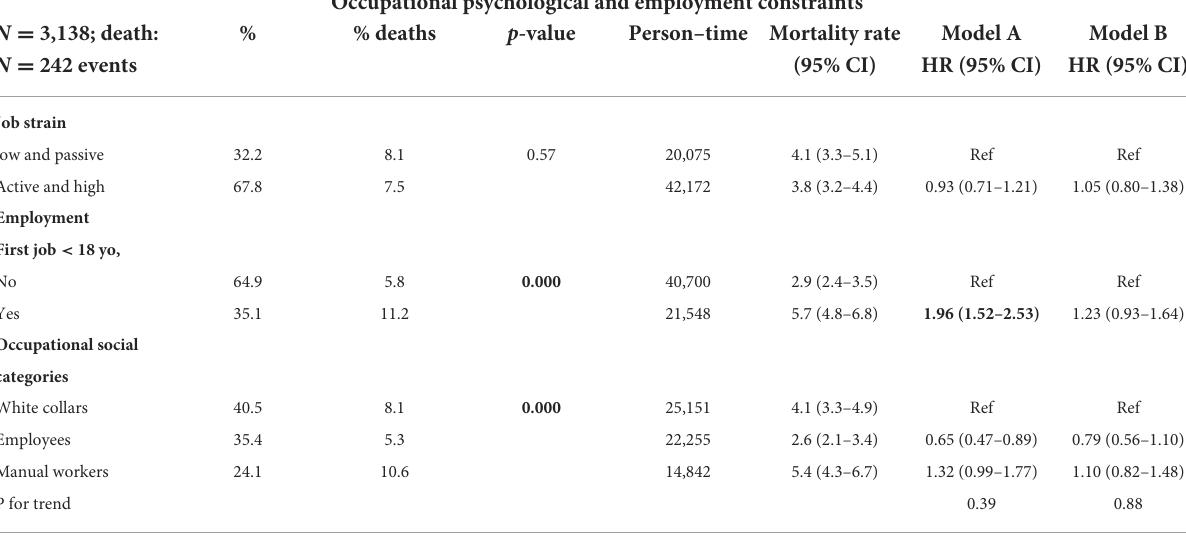
TABLE 3 Occupational psychological and employment constraints and all-cause mortality. Occupational psychological and employment constraints